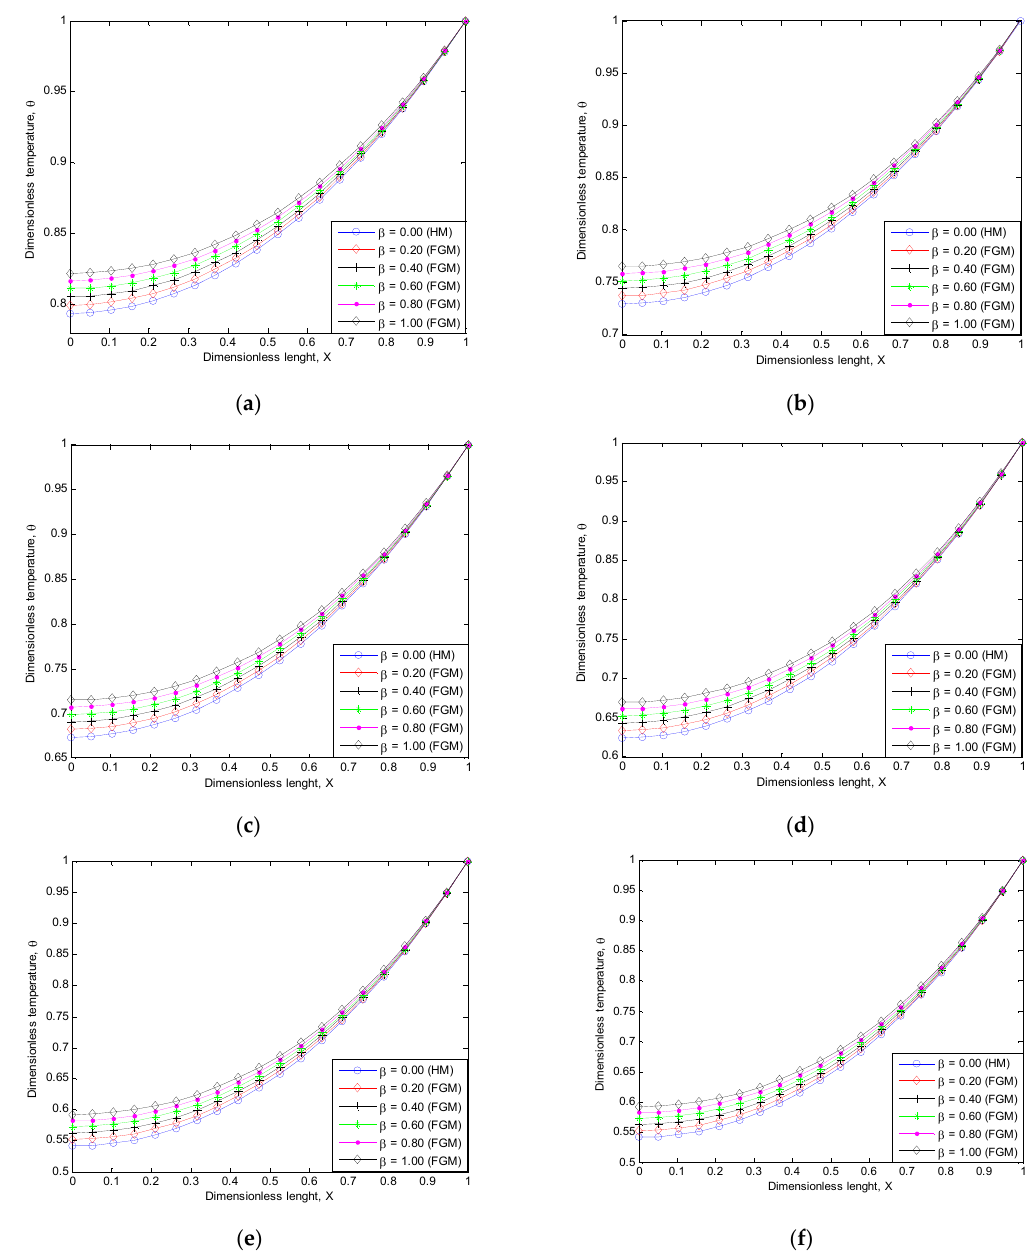
Figure 2. Fin dimensionless temperature profile for varying thermo ‐ geometric parameter under linear ‐ law function when: ( a ) Nr = 0.0, Ra = 0.01, Nc = 1.0; ( b ) Nr = 0.2, Ra = 0.01, Nc = 1.0; ( c ) Nr = 0.1, Rd = 0.01, N c = 1.0; ( d ) Nr = 0.1, Ra = 0.01, Nc = 1.2; ( e ) Nr = 0.1, Ra = 0.01, Nc = 1.5; and ( f ) Nr = 0.2, Ra = 0.01, Nc = 1.2.